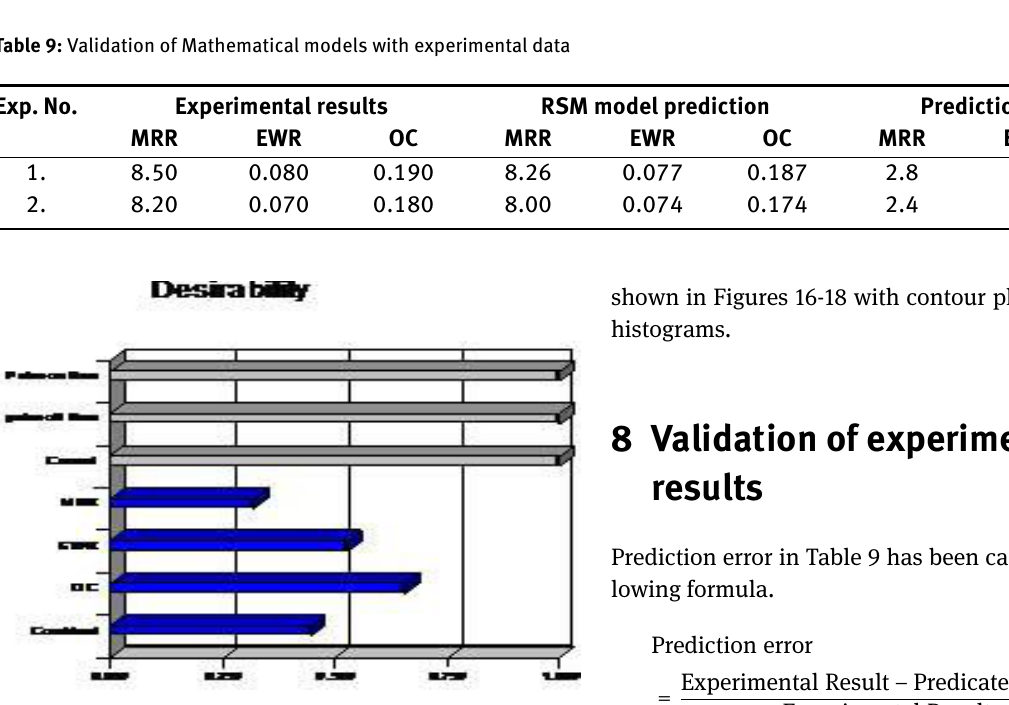
Table 8 shows the composite desirability and the corre- sponding values of predicted responses obtained are